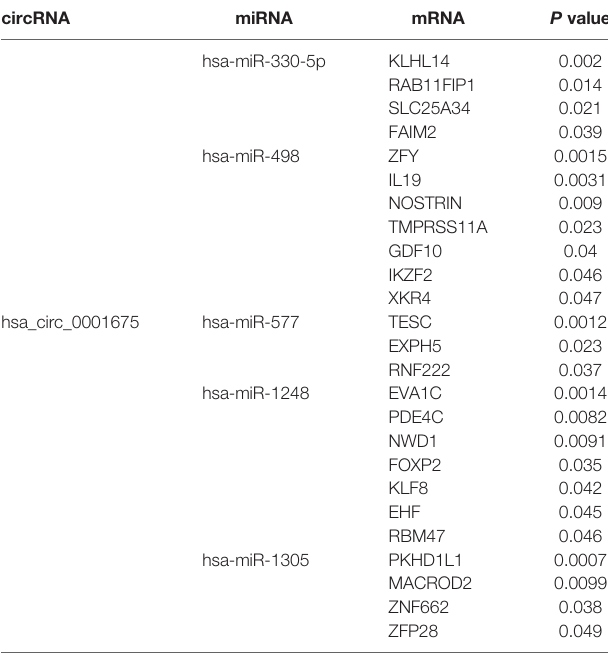
TABLE 3 | The twenty- fi ve predicted mRNAs that have a protective effect on the OS of HNSC ( P < 0.05) and their circRNA-miRNA network.